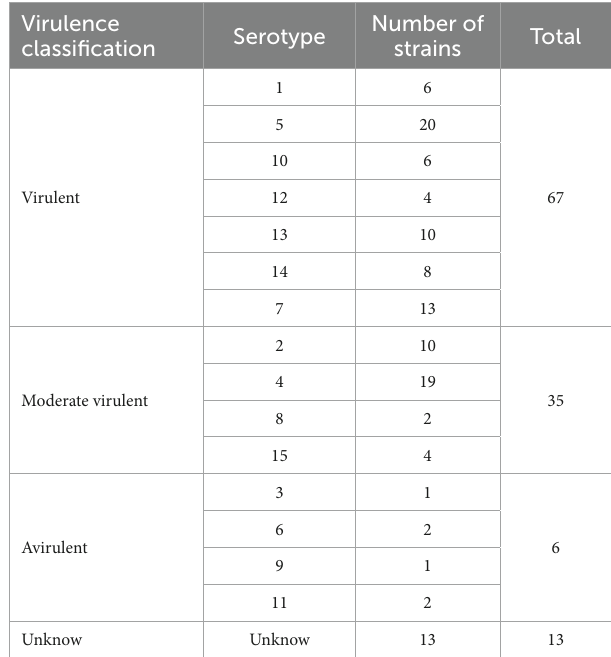
TABLE 2 Classification of the virulence of 121 G. parasuis